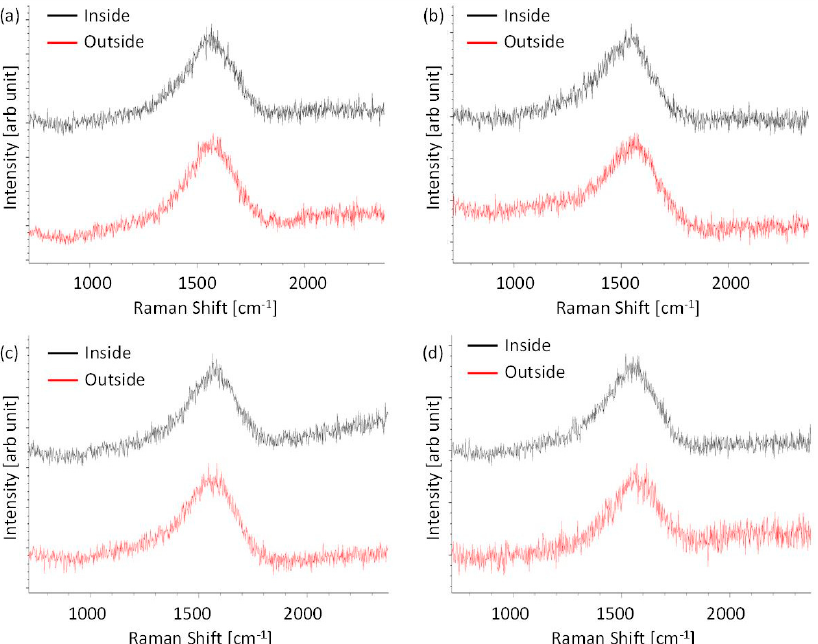
Figure 6. Results of the Raman spectroscopic analyses. ( a ) (BMIM)(DCN) 30 °C, ( b ) (BMIM)(DCN) 170 °C, ( c ) (BMIM)(TCC) 30 °C, and ( d ) (BMIM)(TCC) 100 °C.